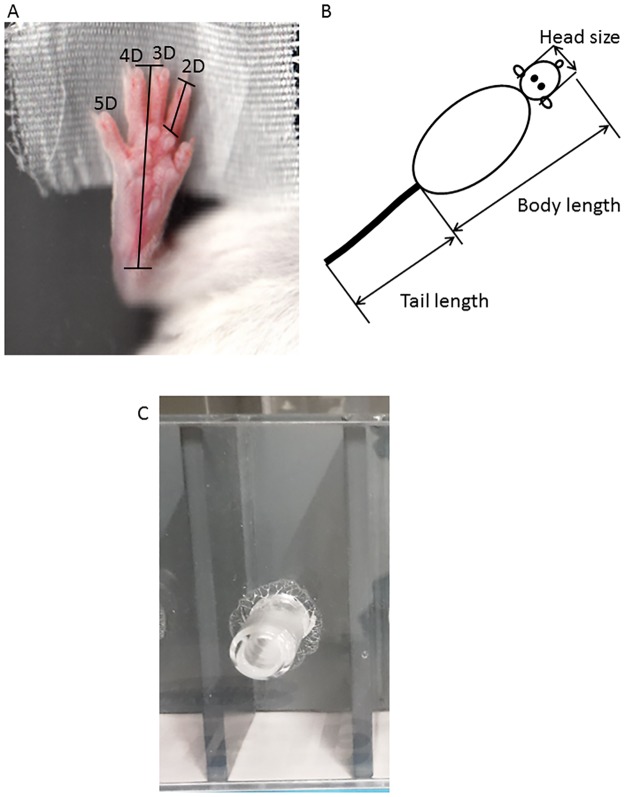
Morphological measurements and handedness box.(A) Scan of a fixed paw with schematic illustration of digit measurement. (B) Sketch of mouse with illustration of morphological parameters. (C) Picture of a compartment of the handedness box. Mice were placed in the box and reaches with one paw through the tubing to obtain a food pellet were counted.